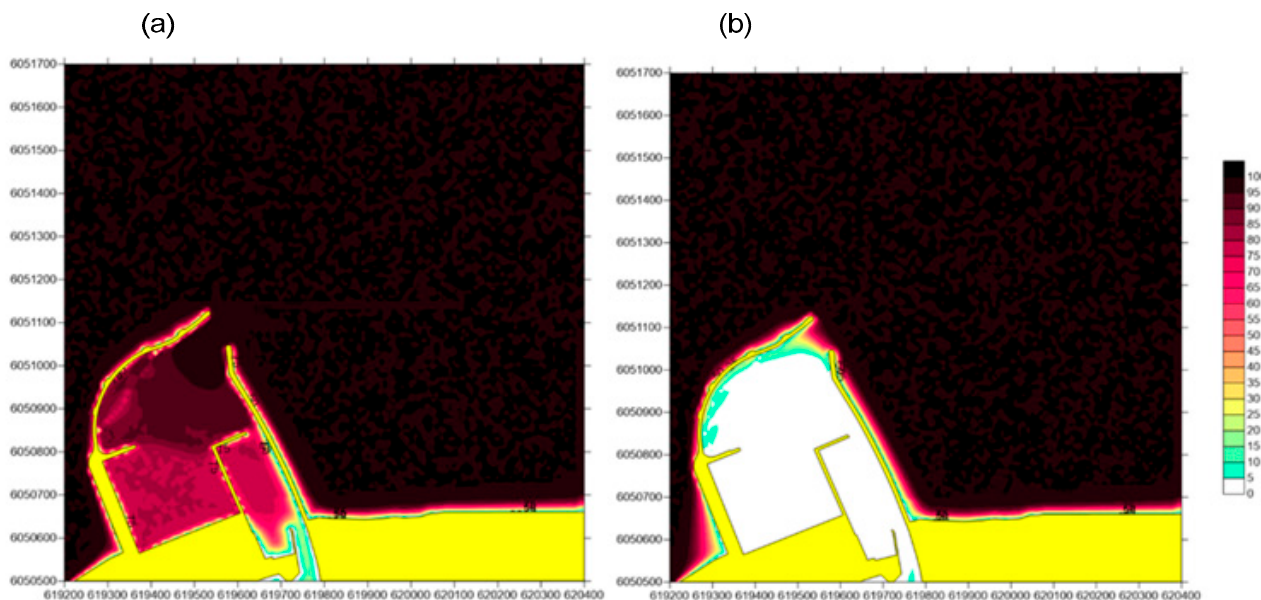
Figure 4. Selected elements of environmental modelling. ( a ) wind scale-up factors for NE winds, ( b ) wave scale-up factors for NE wave system.